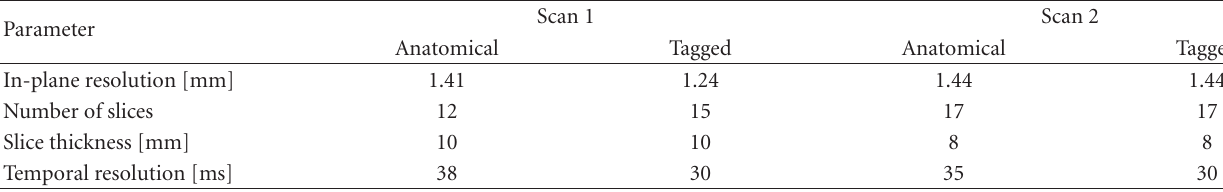
Table 1: Parameters of the anatomical and tagged MR